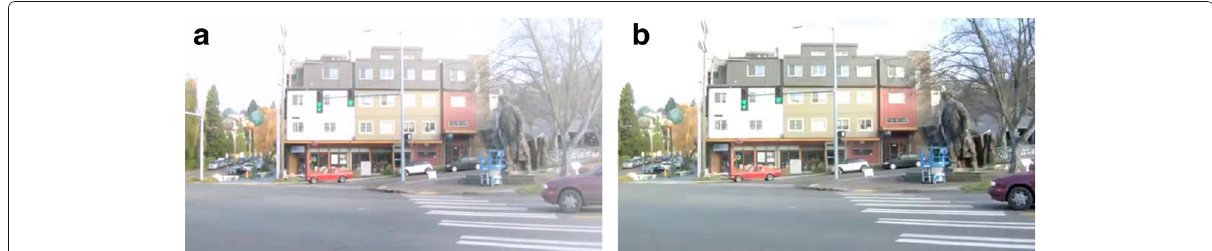
Fig.7 Video #1 . Amount of pixels hold through our method is superior than the state-of-the-art approach. a Adaptive Gaussian filter; b YouTube [24]